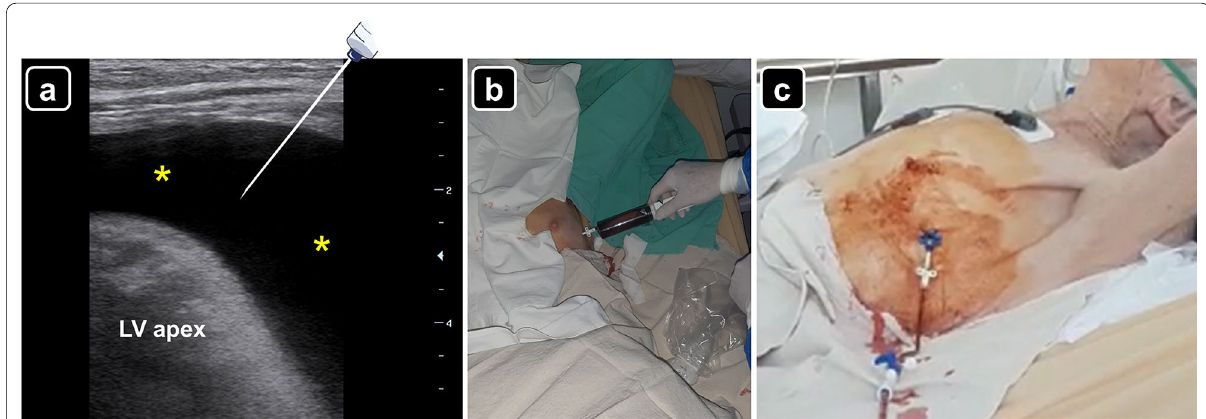
Fig. 2 a Pericardial effusion (asterisks) observed with a linear probe in the cardiac apex region. A needle-syringe is illustrating the path to reach the pericardial cavity. LV left ventricular apex. b Pericardiocentesis via the apical approach freely obtaining an abundant hematic fluid. c Pericardial catheter drainage inserted through the Seldinger technique